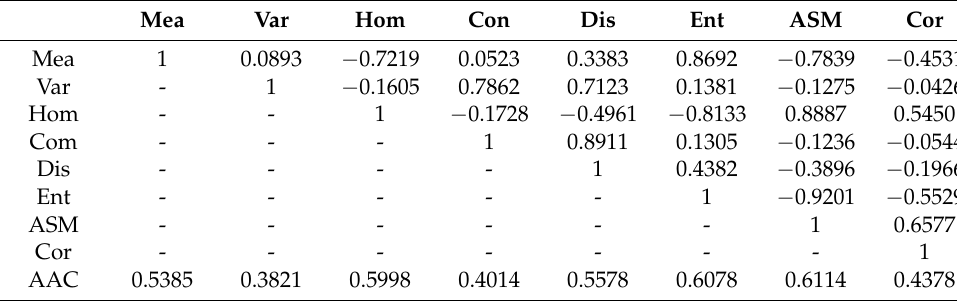
Table 2. Correlation matrix for eight texture components in the Bohai Bay data set. Mea Var Hom Con Dis Ent ASM